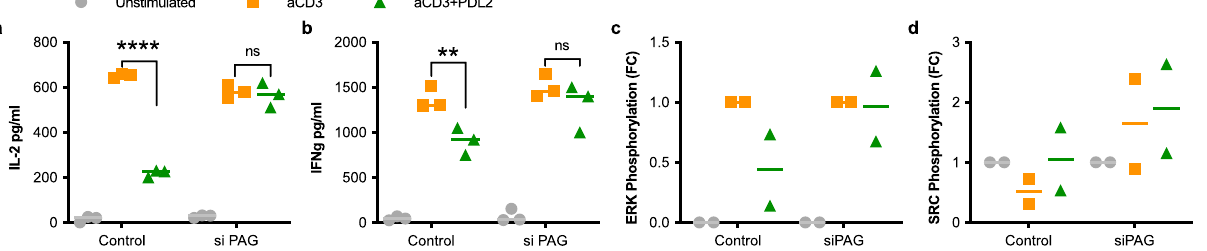
Fig. 2 PAG contributes to PD-1 signaling in primary T cells. a , b ELISA of secreted IL-2 ( a ) and IFN γ ( b ) in the supernatants of primary human CD3 +